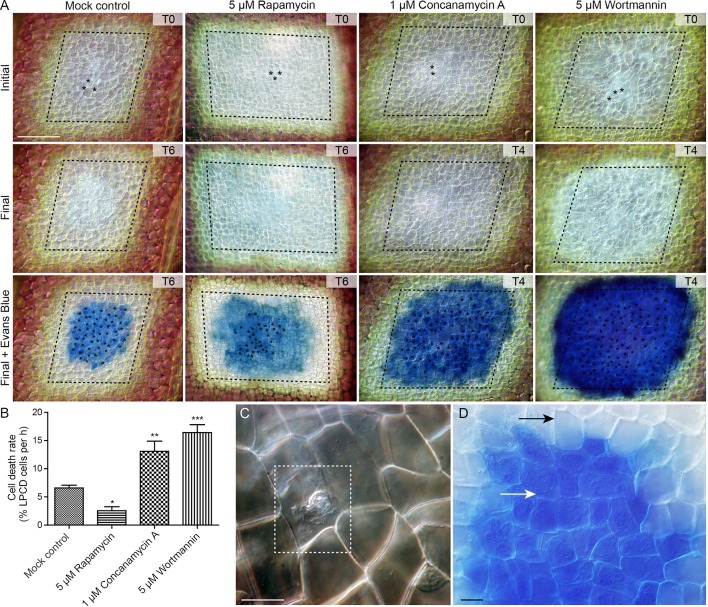
Cell death assay. (A) Initial and final micrographs of window stage leaves. Evans blue staining was performed at the end of the experiments to facilitate the final scoring of cell death in epidermal cells (asterisks). Treatments included 0.05% DMSO (mock control), 5 µM rapamycin, 1 µM concanamycin A, or 5 µM wortmannin. T = time, rounded to the nearest h. (B) The rate of cell death was calculated as the % of late programmed cell death (LPCD) cells that died per hour. (C) High magnification view of unstained dead epidermal cell (dashed box) in a window stage leaf. Evans blue staining (D) was used to facilitate quantification of dead cells in the epidermis (white arrow) at the end of experiments. Black arrow = living cell with intact plasma membrane. One-way analysis of variance, Dunnett multiple-comparisons test, n ≥ 6 leaves from individual plants; ***P < 0.001; **P < 0.01; *P < 0.05). Error bars represent standard error. Scale bars: A = 150 µm; C and D = 5 µm. (For more details, see 
Supplementary File 5
.)